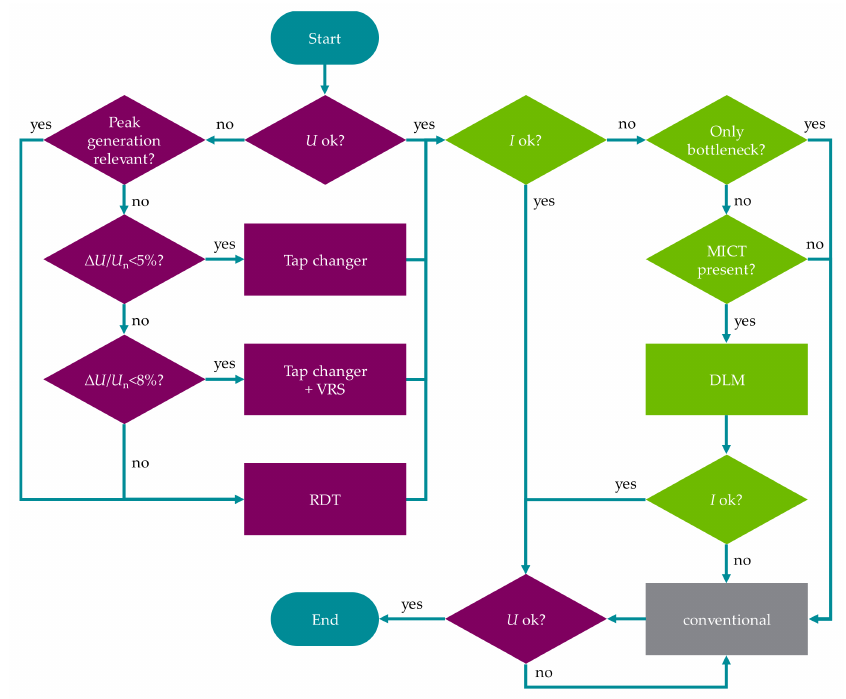
Figure 36. Decision path for strategic grid planning of urban low-voltage grids, with: “ok” = compliance with the specified limit values, bottleneck = short line section (length and/or small cross-section), ∆ U / U n = additional voltage difference beyond the lower voltage band according to [11].